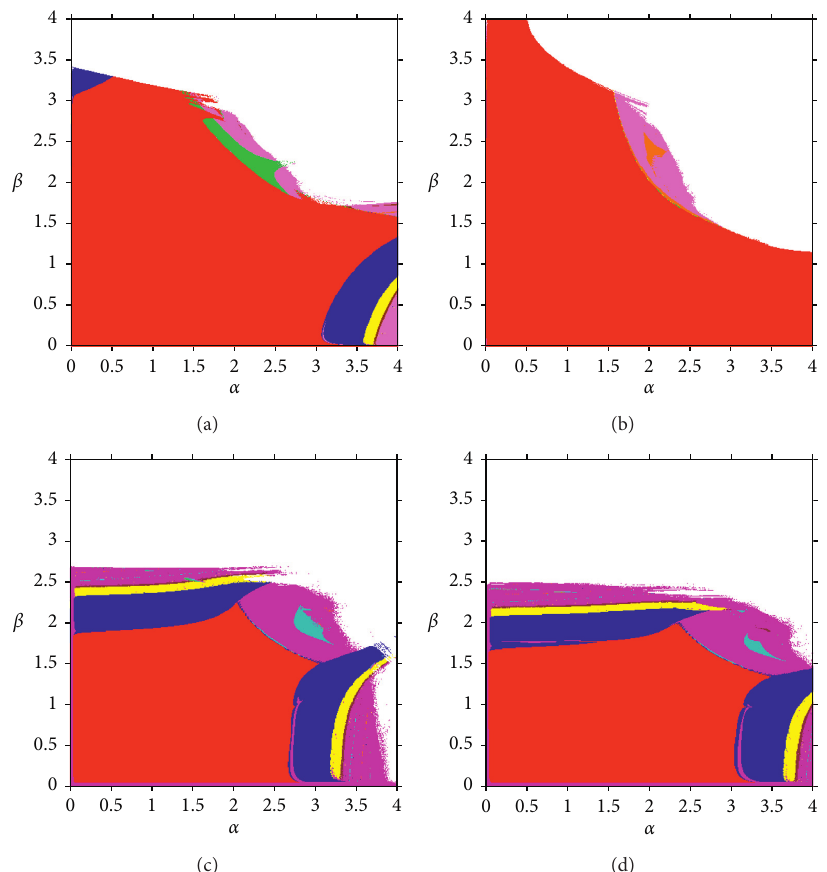
Figure 2: The parameter basins of the dynamic system (12) under different parameter values: (a) d � 0 . 5; (b) d � 0 . 8; (c) c � 0 . 2; (d) c � 0 . 3.